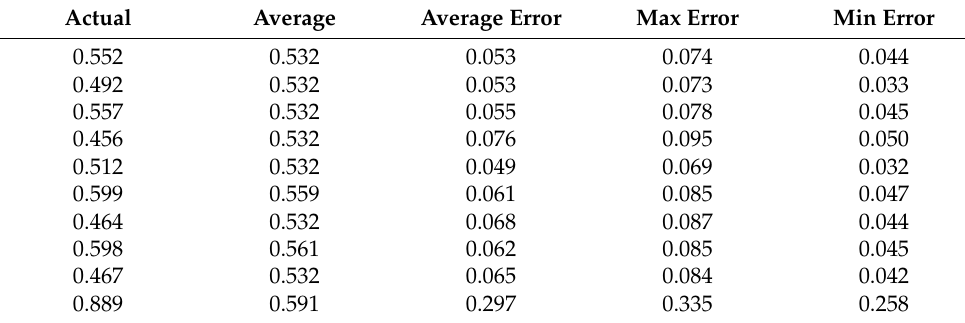
Table A33. Set 1, trials 21–30 data (actual PR value).